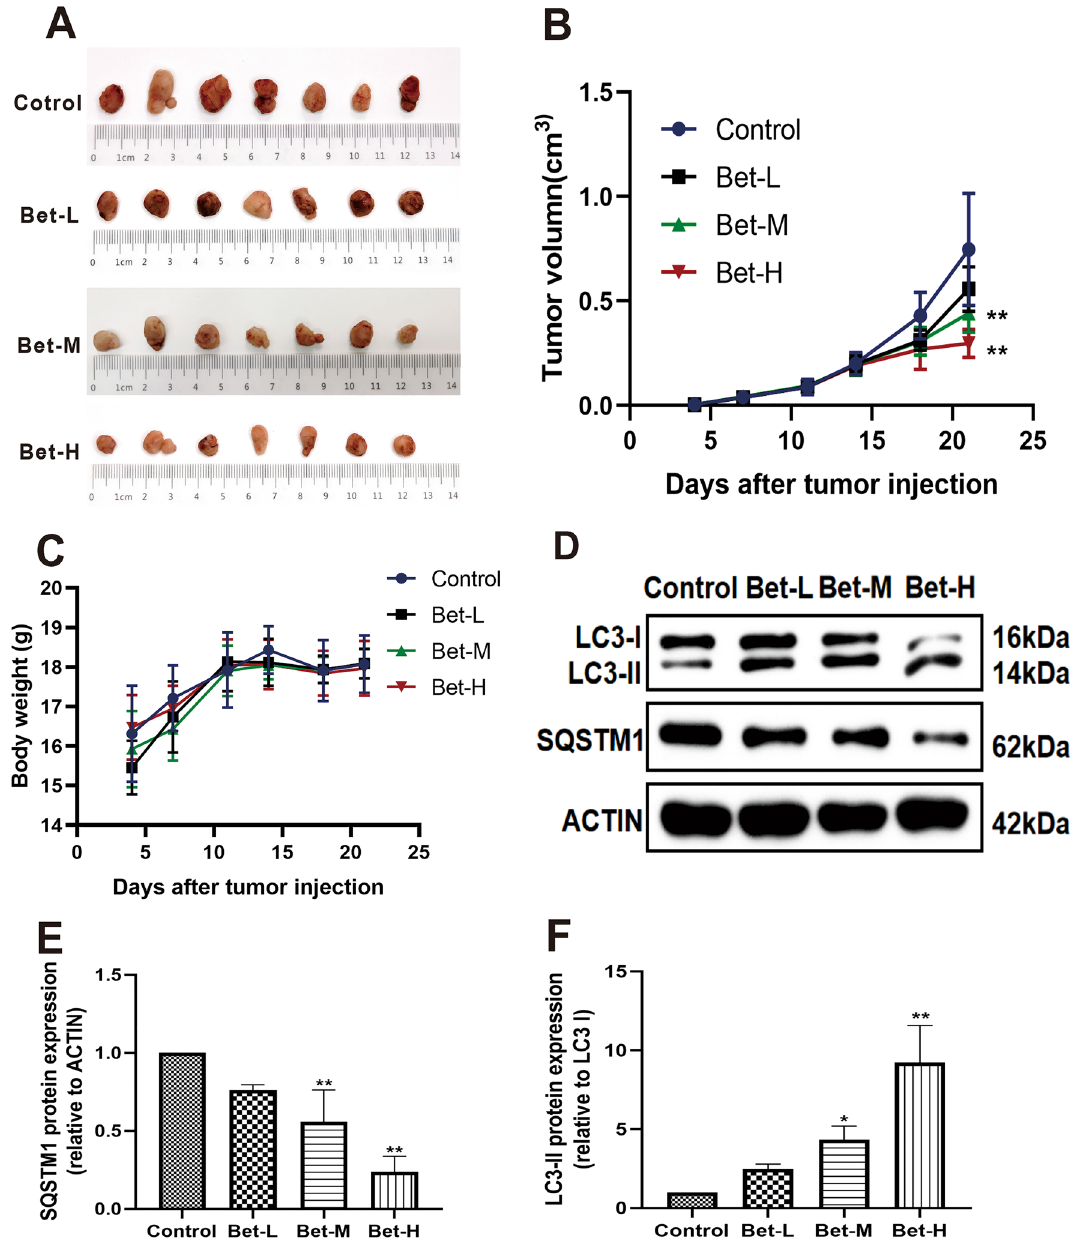
Figure 7. Betulinaldehyde inhibited the growth of A549 tumor xenografts in nude mice in vivo. After adaptive feeding for one week, A549 cells were implanted into nude mice via subcutaneous injection under the axilla, and the mice were treated with different concentrations of betulinaldehyde when the tumor grew to a suitable size. ( A ) The xenograft tumors were separated when the animals were killed. ( B ) The tumor growth was measured every 4 days. Results were presented as mean ± SD (n = 7). ( C ) The total body weight was monitored for 21 days. ( D – F ) The expressions of SQSTM1 and LC3-II were tested at the protein level and the data were quantitated to be represented as mean ± SD (n = 3). Cropped images are displayed, uncropped blots are displayed in Supplementary Fig. 4. The images were collected from different parts of the same gel with same loading amounts. The blot gels shown are representatives of three different experiments (n = 3). Comparisons among multiple groups were performed using one-way analysis of variance. The differences between control and treatment groups were analyzed using LSD multiple comparison test. * P < 0.05, ** P < 0.01 versus control group, # P < 0.05, ## P < 0.01 versus Bet group (Bet-L = betulinaldehyde [50 mg/kg]; Bet-M = betulinaldehyde [100 mg/kg]; Bet-H = betulinaldehyde [200